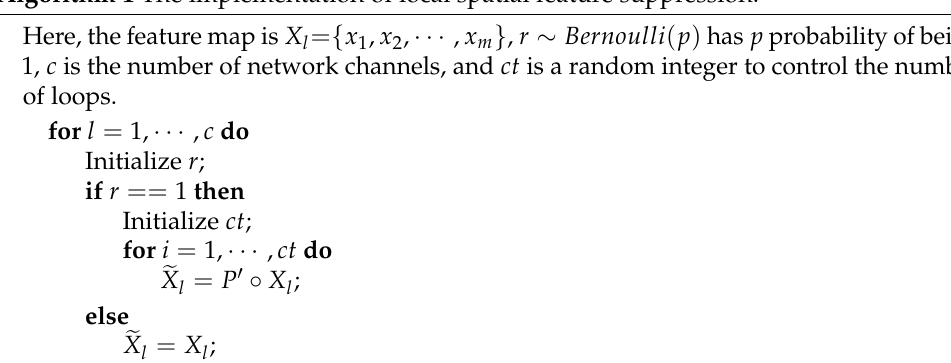
Figure 4. Overview of local spatial feature suppression strategy. Algorithm 1 The implementation of local spatial feature suppression.